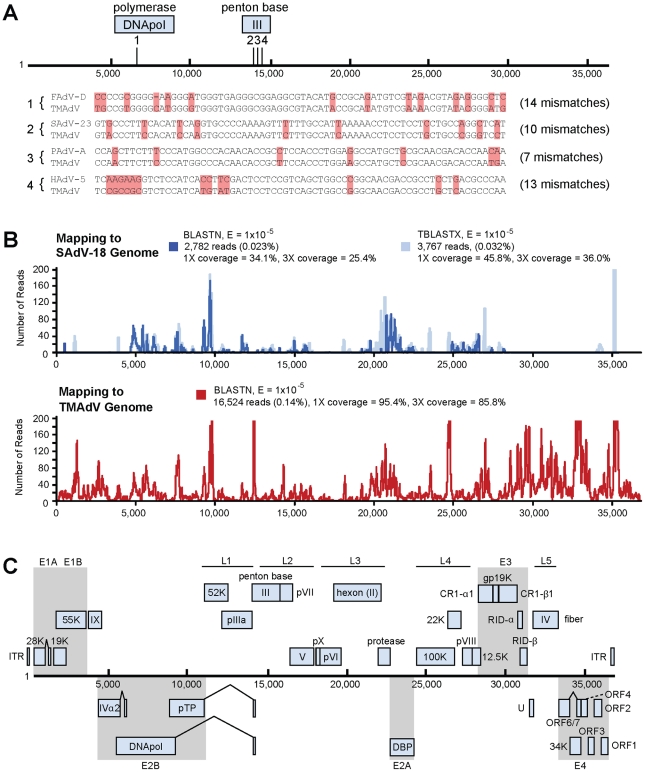
Discovery and whole-genome characterization of the novel adenovirus TMAdV.(A) The locations of the 4 Virochip probes derived from adenovirus sequences and used to detect TMAdV are mapped onto the ∼37 kB genome. The 4 Virochip probe sequences are also aligned with the corresponding sequence in the TMAdV genome, with mismatches highlighted in pink. (B) Coverage map of deep sequencing reads corresponding to TMAdV using BLASTN (blue) and TBLASTX (transparent blue) alignments to SAdV-18. The actual coverage achieved by deep sequencing as determined by alignments to the fully sequenced genome of TMAdV is much higher (red). (C) Genome organization of TMAdV. Predicted protein coding regions are shown as boxes. Boxes above the central black line represent open reading frames (ORFs) that are encoded on the forward strand, while boxes underneath the black line represent reverse-strand encoded ORFs. Early region ORFs are shaded in gray. The x-axis refers to the nucleotide position along the ∼37k genome of TMAdV. Abbreviations: FAdV, fowl adenovirus; SAdV, simian adenovirus; PAdV, porcine adenovirus; HAdV, human adenovirus, TMAdV, titi monkey adenovirus.